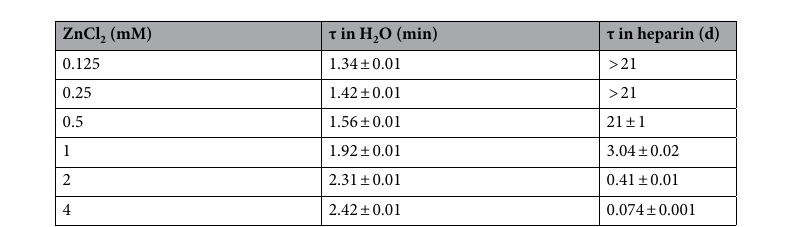
Table 1. Determined time constants for the dynamic transmetallation (τ in H 2 O) and dynamic transchelation (τ in heparin) experiments. The values for τ in heparin for 0.125 mM and 0.25 mM ZnCl 2 could not be fitted reliably and were thus just estimated to be larger than the 21 days as determined for 0.5 mM ZnCl 2 .